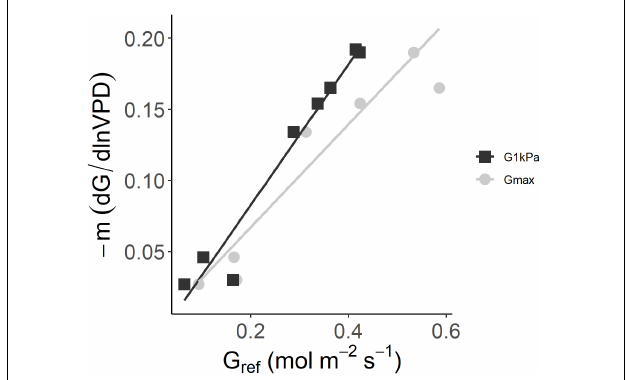
FIGURE 3 | The sensitivity of average stomatal conductance at site level to increasing vapor pressure deficit (– dG/d lnVPD) as a function of the canopy stomatal conductance at VPD = 1 kPa and at its maximum value. The two axes represent the slope and intercept of the relationship G = – m ln(VPD) – b . G@1 kPa: y = 0.50X–0.016 ( R 2 = 0.96; G max : y = 0.36X–0.005 ( R 2 =